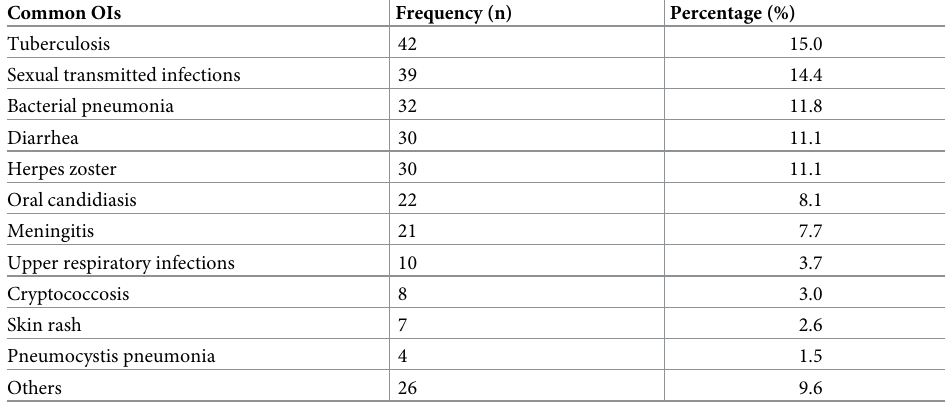
Table 3. Common opportunistic infections during follow-up in adults living with HIV on ART at Debre Markos Comprehensive Specialized, Northwest Ethiopia, 2021.